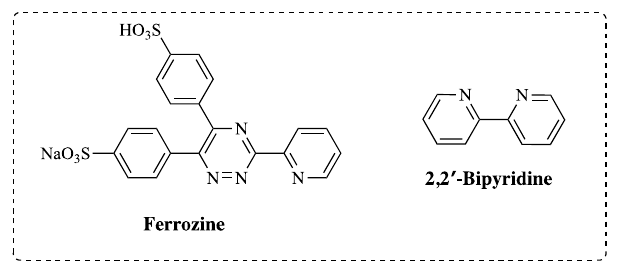
Figure 3. The chemical structures of ferrozine and 2,2 ′ -bipyridine as metal chelator. FeCl 2 and FeSO 4 are generally used as sources of ferrous ion (Fe 2+ ). The decrease in absorbance at 485 nm for 2,2 ′ -bipyridine or 562 nm for ferrozine after transferring the metal ion to an antioxidant indicates the formation of the metal-antioxidant complex [131].